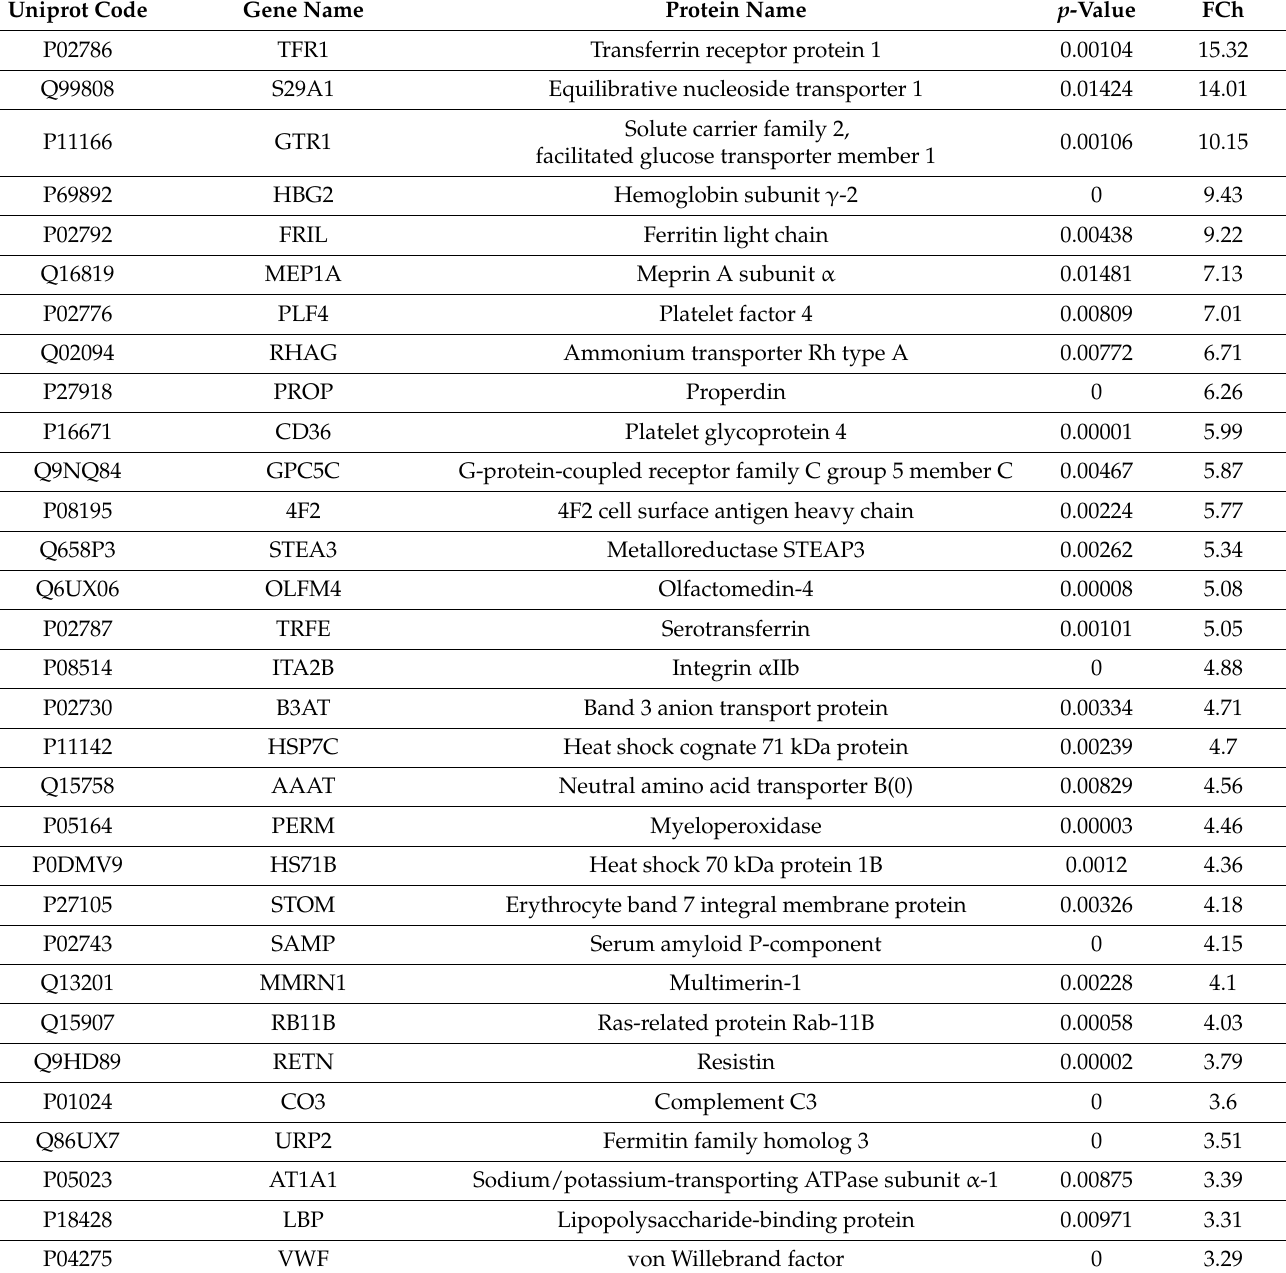
Table 1. Differential protein expression identified by sequential window acquisition of all theoretical mass spectrometry (SWATH MS) in plasma exosomes from neonates vs. adults ( p < 0.05; FCh > 2 or <0.5). Uniprot